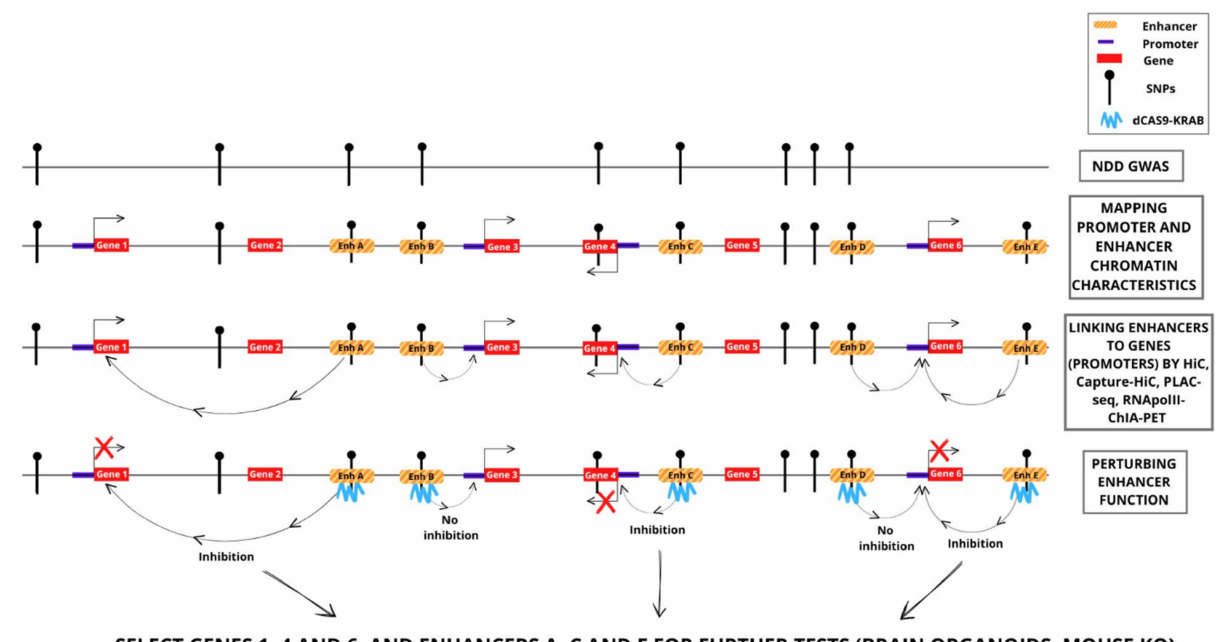
Figure 2. Identification and functional investigation of enhancer–gene promoter interactions involv- ing DNA sequence variants (SNPs) associated to NDD. Examples of the strategies discussed in the text, and of possible results. Perturbation, by CRISPR-dCas9KRAB, of enhancers A, C and E inhibits the connected genes (genes 1, 4 and 6, respectively); perturbation of enhancers B and D does not inhibit the connected genes. Thus, genes 1, 4 and 6 are candidate NDD genes. Gene 4 was also previously suggested to be an NDD gene by polymorphic variation (SNP) within the gene, associated by GWAS to